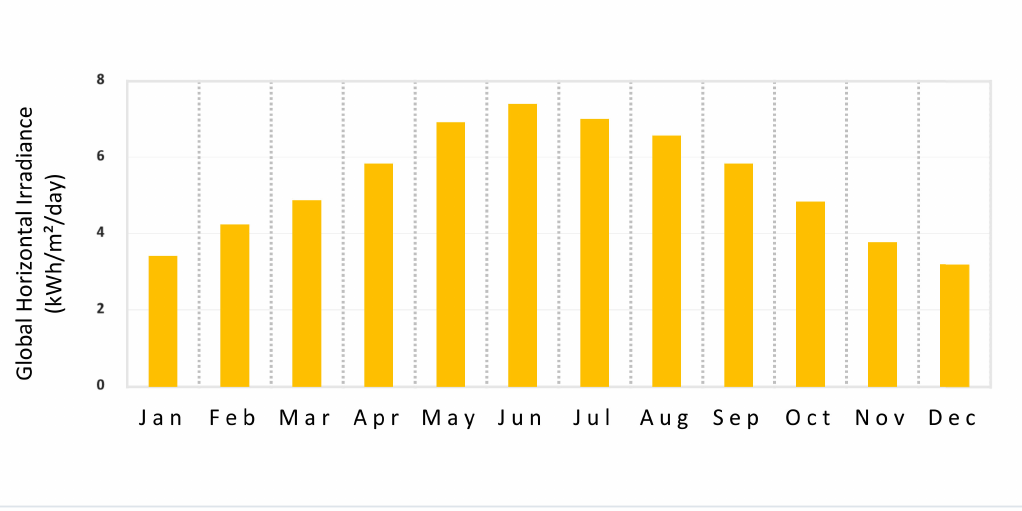
Figure 2. Monthly average solar Global Horizontal Irradiance (GHI) in